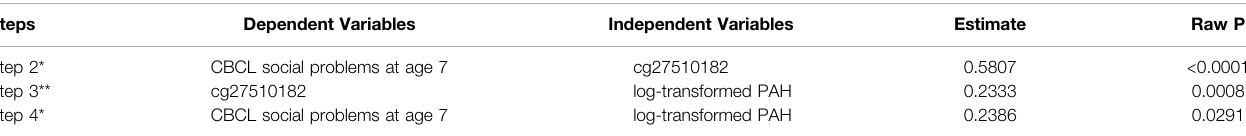
TABLE 6 | Overall fi ndings of CpG cg27510182 from each step in the discovery dataset with 240